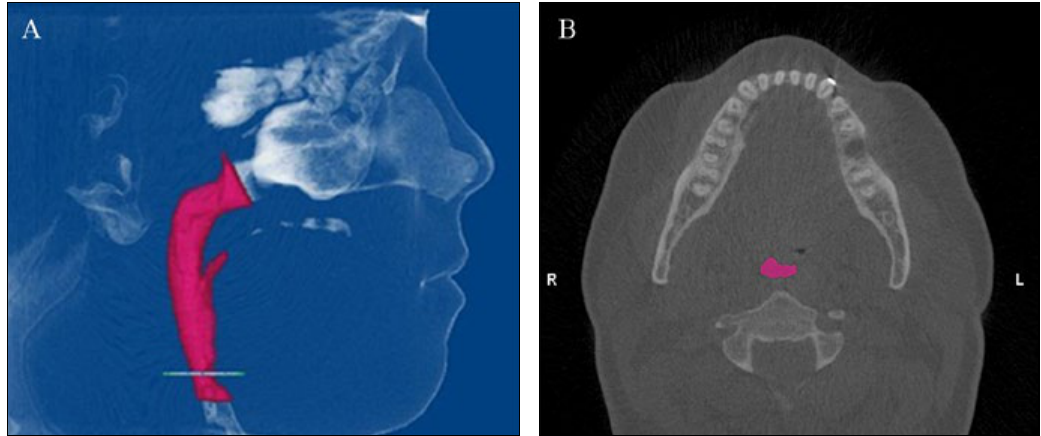
Figure 3. (A) Total airway volume and (B) cross sectional view of the most constricted area.